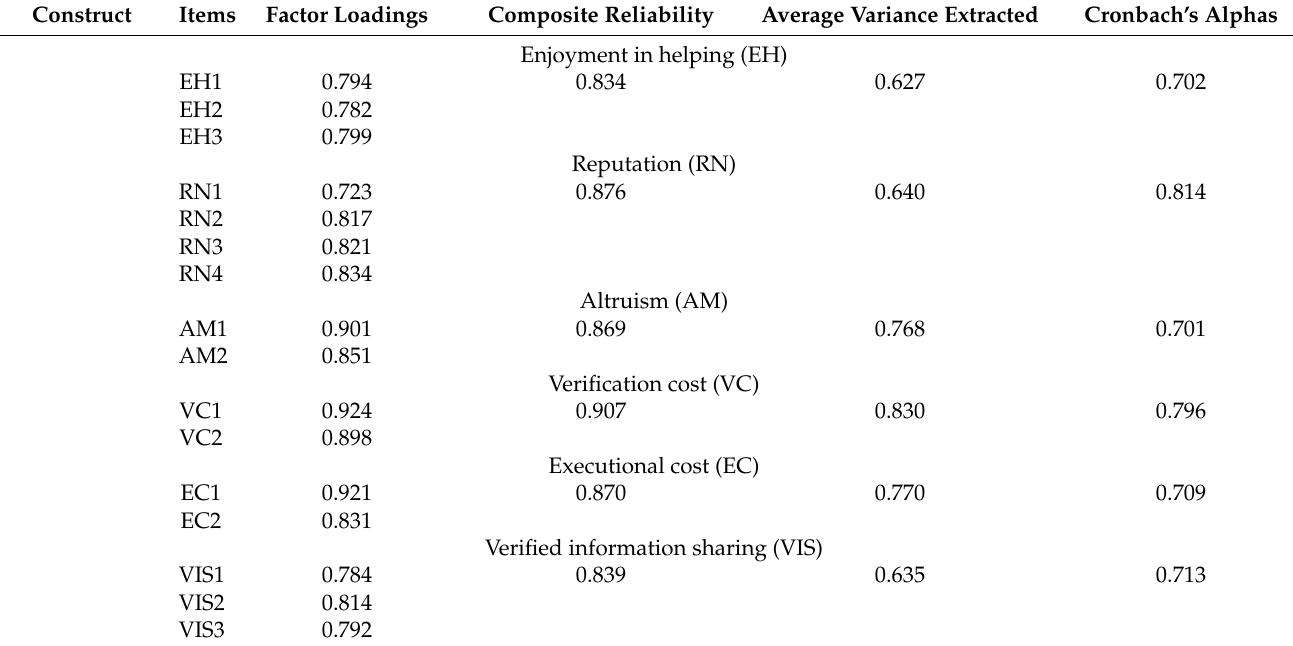
Table 2. Construct reliability and convergent validity.